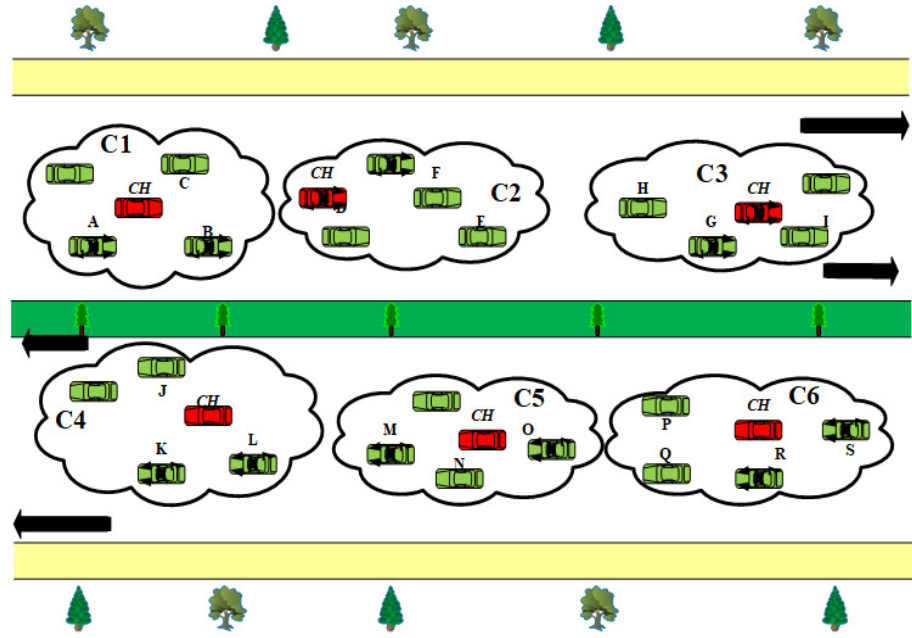
Figure 4. Dissemination of warning messages with different scenarios.